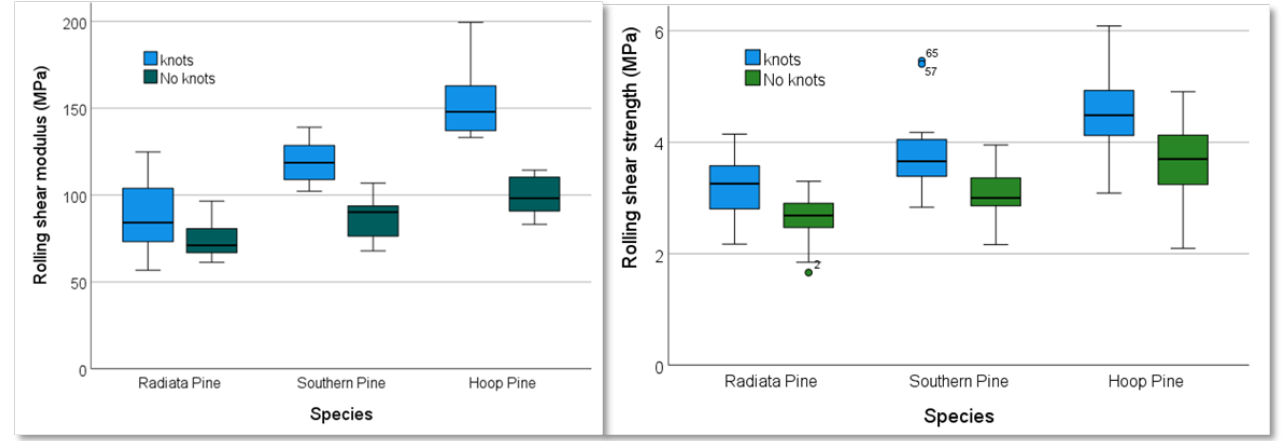
Figure 15. Boxplot showing effect of RS modulus ( left ) and strength ( right ) for various species.